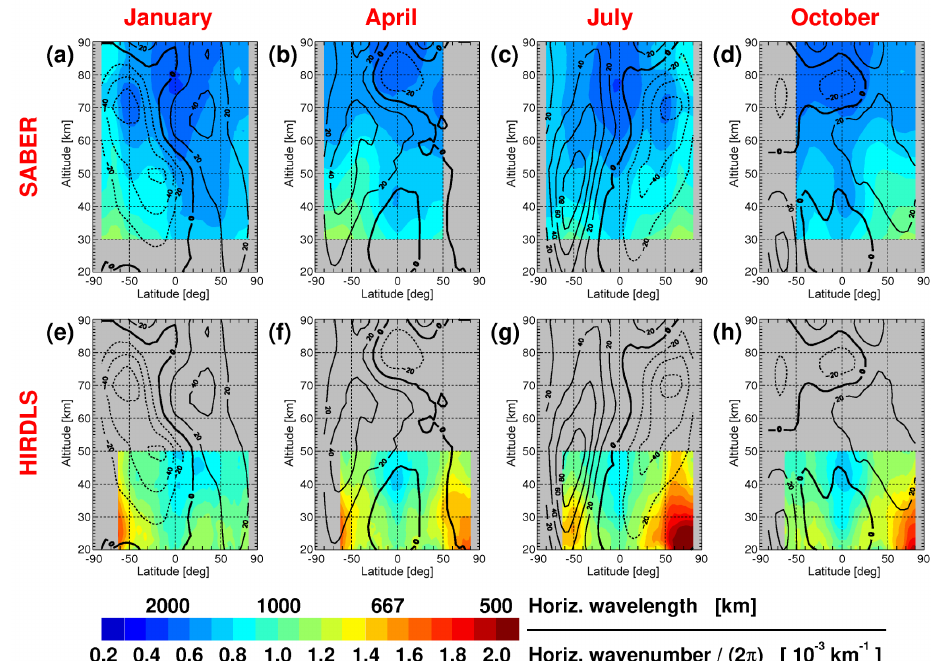
Figure 10. Latitude–altitude cross sections of zonal-average gravity wave horizontal wavenumbers k h / (2 π ) (i.e., average reciprocal hori- zontal wavelengths) from those pairs of altitude profiles that are also used to calculate momentum fluxes. Values are in 10 − 3 km − 1 . Shown are multi-year averages for SABER (a–d) and HIRDLS (e–h) for the months of January (a,e) , April (b,f) , July (c,g) , and October (d,h) . Overplotted winds are from the SPARC climatology (Swinbank and Ortland, 2003; Randel et al., 2002, 2004). Westward (eastward) winds are indicated by dashed (solid) contour lines. The zero wind line is bold solid. The contour line increment is 20ms − 1